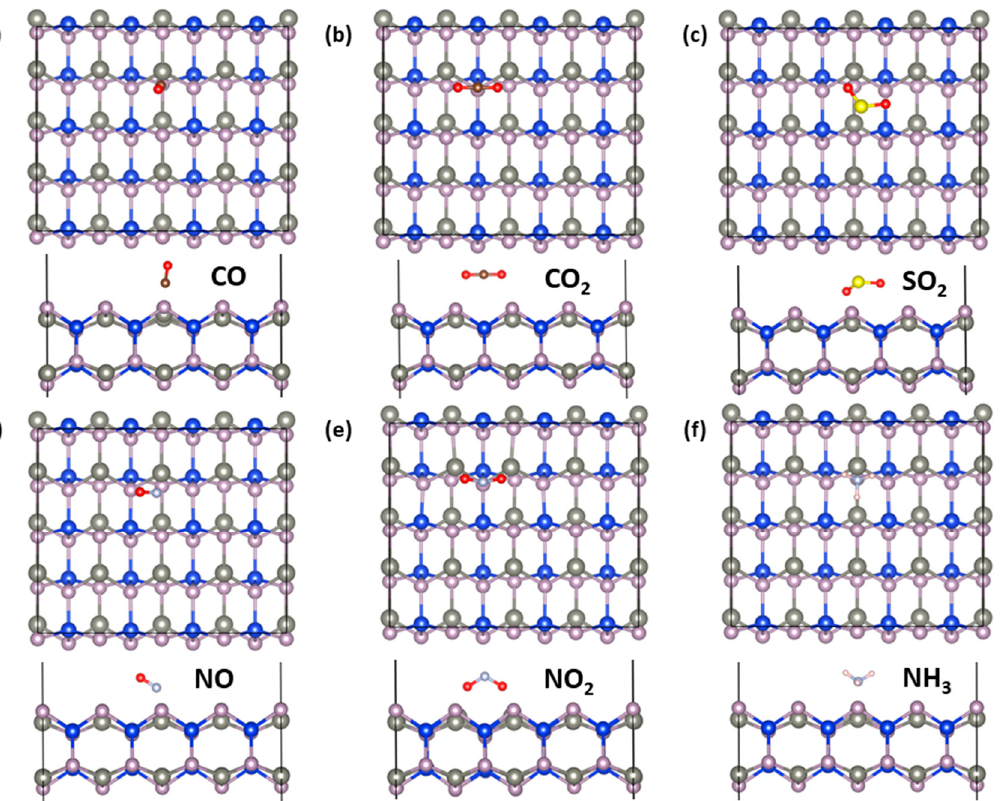
Figure 9. Top and side views of the most stable adsorption of the small gas molecules ( a ) CO, ( b ) CO 2 , ( c ) SO 2 , ( d ) NO, ( e ) NO 2 , and ( f ) NH 3 on the ZnSiP 2 monolayer. (The gray, brown, red, yellow, and pink balls represent N, C, O, S, and H atoms, respectively.)